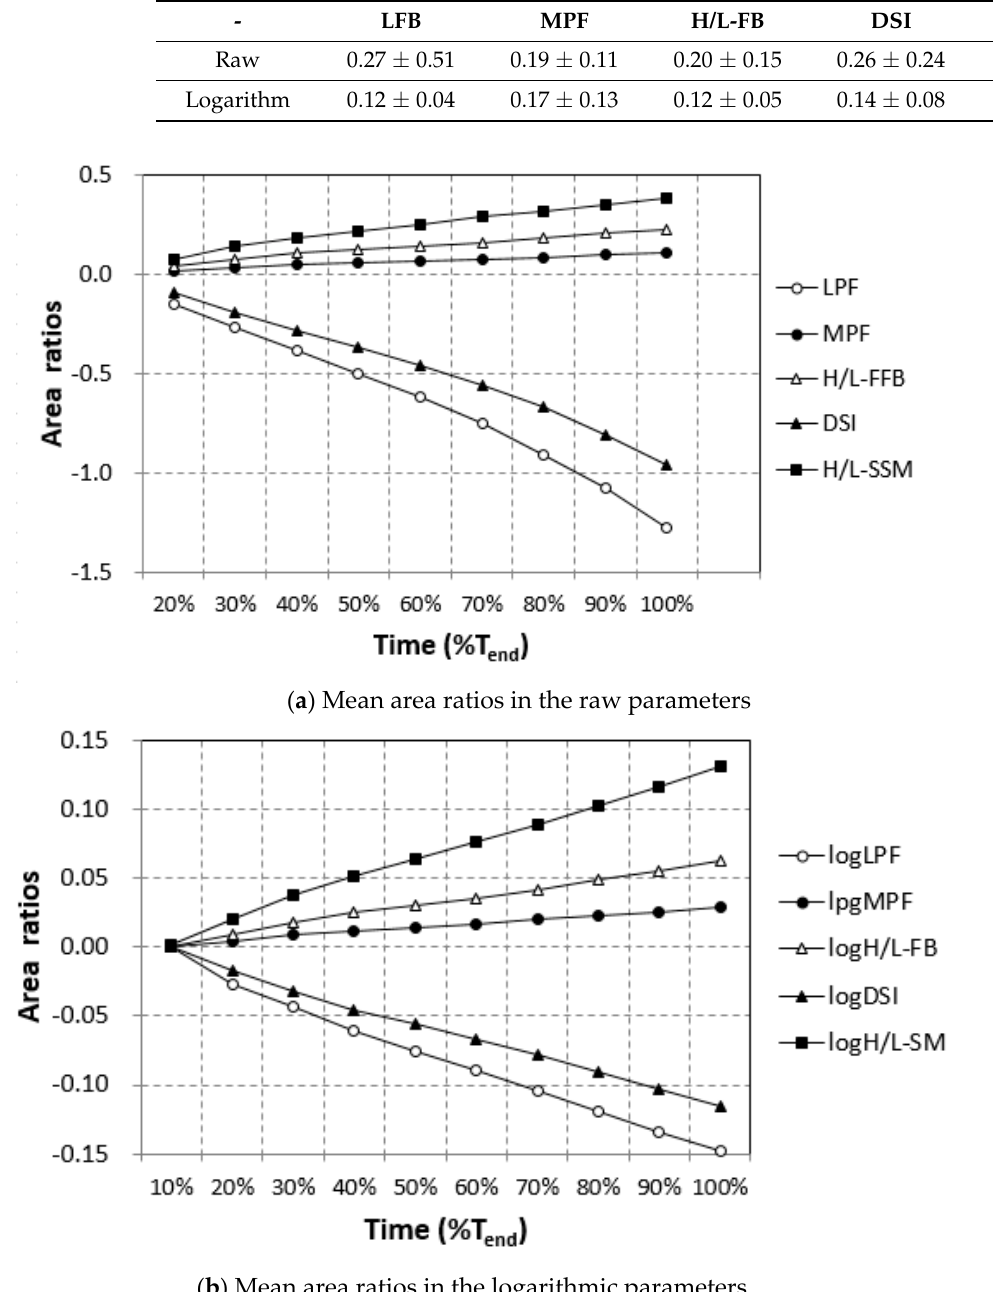
Figure 9. The time series of area ratios in the sEMG raw parameters ( a ) and logarithmic ones ( b ) with respect to time as estimated over every 10% of T end (White circle: LFB and logLFB; Black circle: MPF and logMPF; White triangle: H/L-FB and logH/L-FB; Black triangle: DSI and logDSI; Black square: H/L-SM and logH/L-SM).